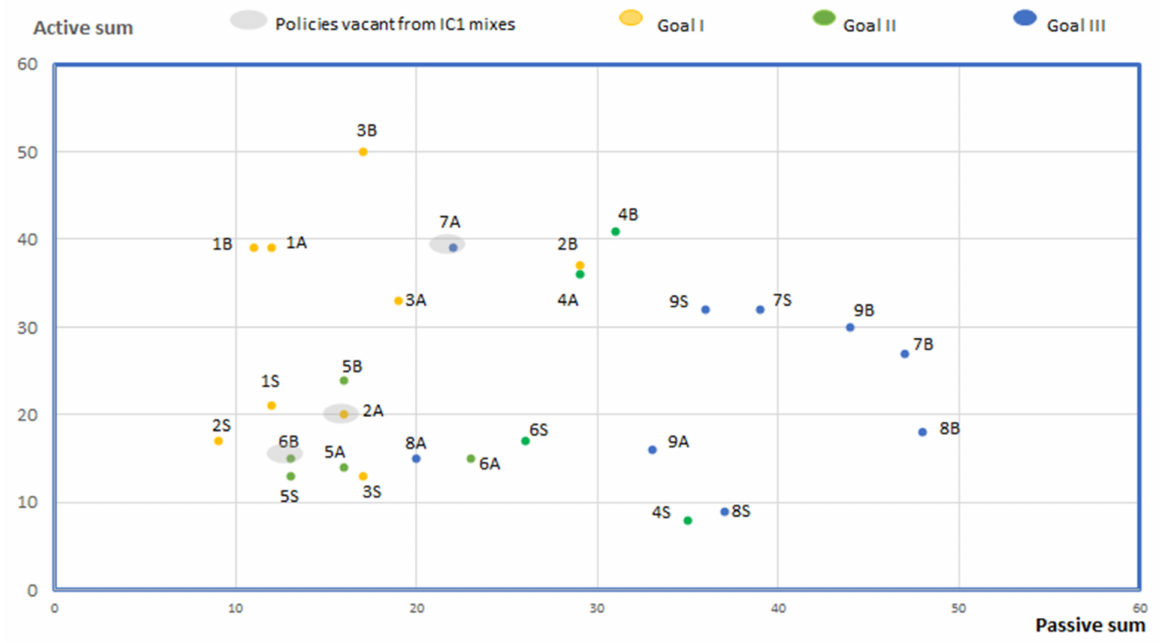
Figure 4. Active and passive sum of all individual